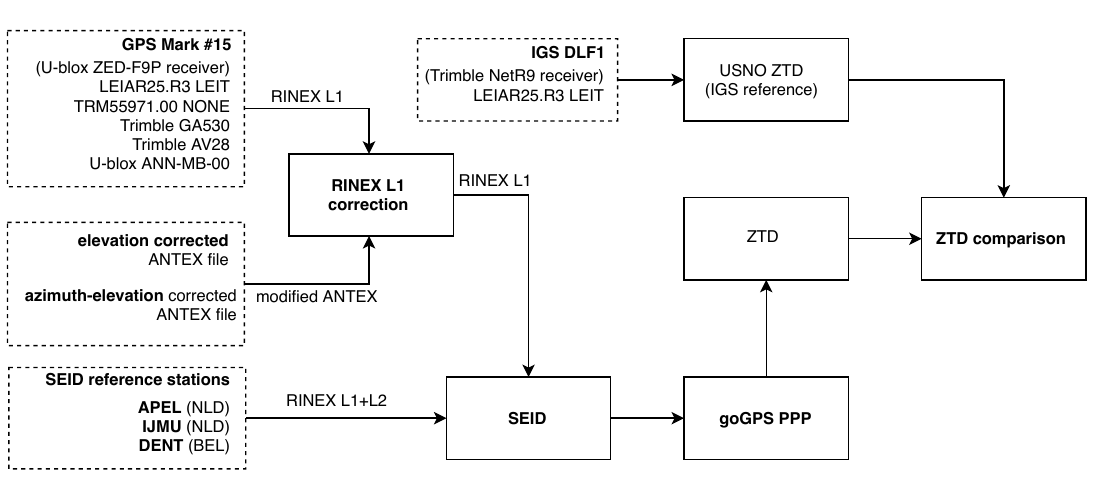
Figure 4. Satellite-specific Epoch-differenced Ionospheric Delay model (SEID) PPP